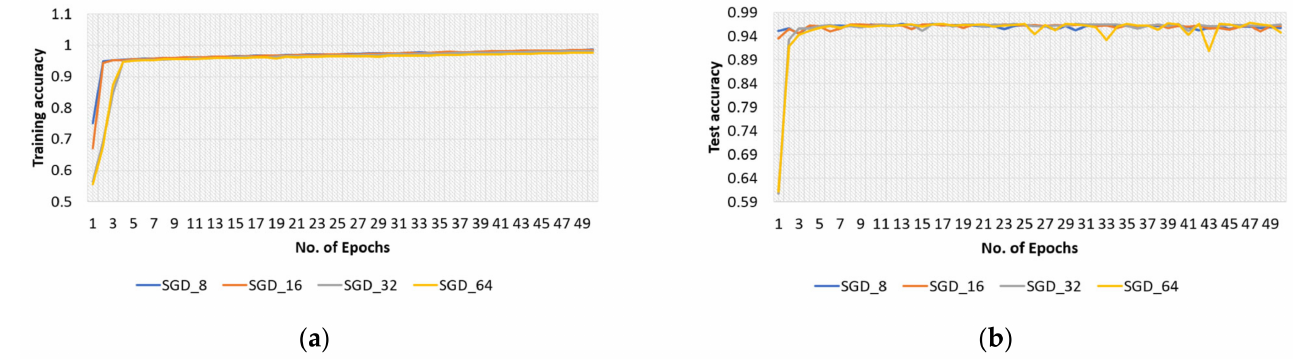
Figure 7. Accuracy curves of ( a ) training and ( b ) test phases of the proposed model obtained with original dataset and SGD optimizer.